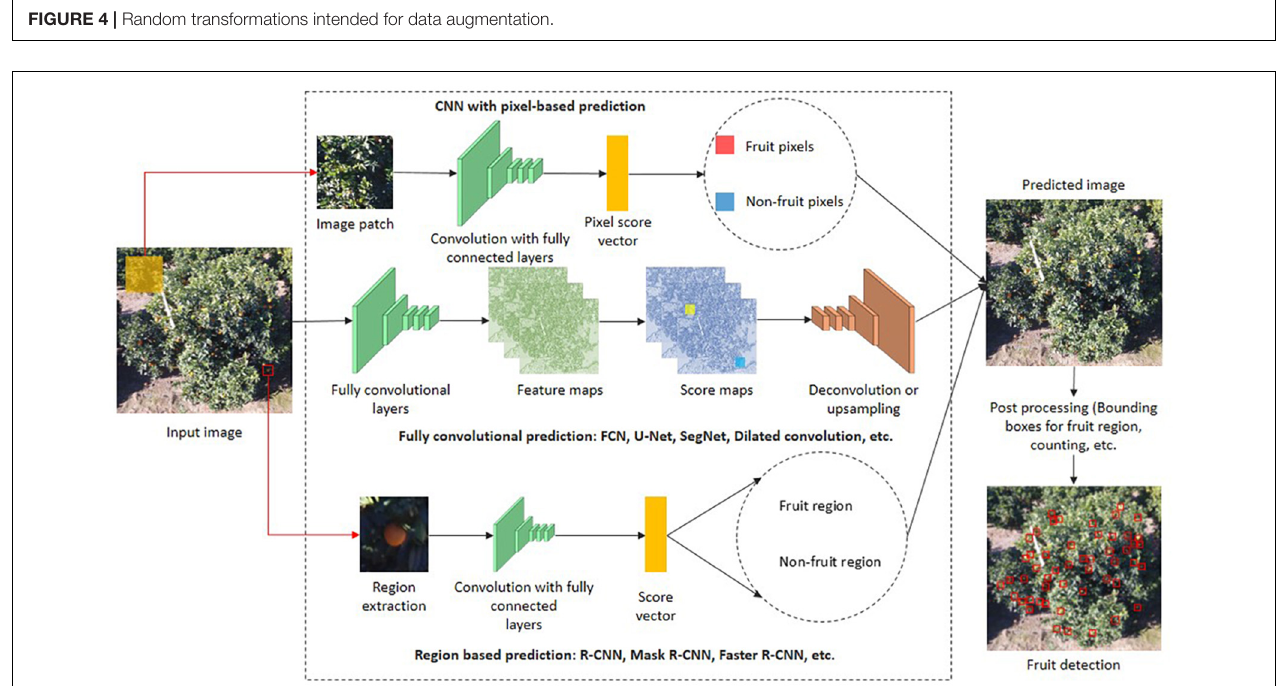
FIGURE 5 | Fruit detection and localization using various DL-based semantic segmentation techniques.